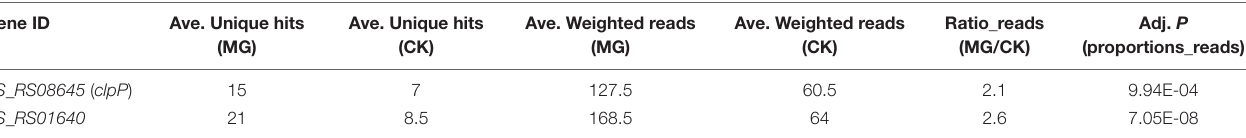
FIGURE 1 | Transposon sequencing (Tn-seq) analysis of gene essentiality for methyl gallate (MG). (A) Schematic diagram of Tn-seq for the identification of resistance genes and target genes for MG. (B) Coefficient of reads coverages for Tn-seq biological replicates (scatter plot) and for all Tn-seq samples (heatmap). TABLE 1 | Potential target genes for MG identified by